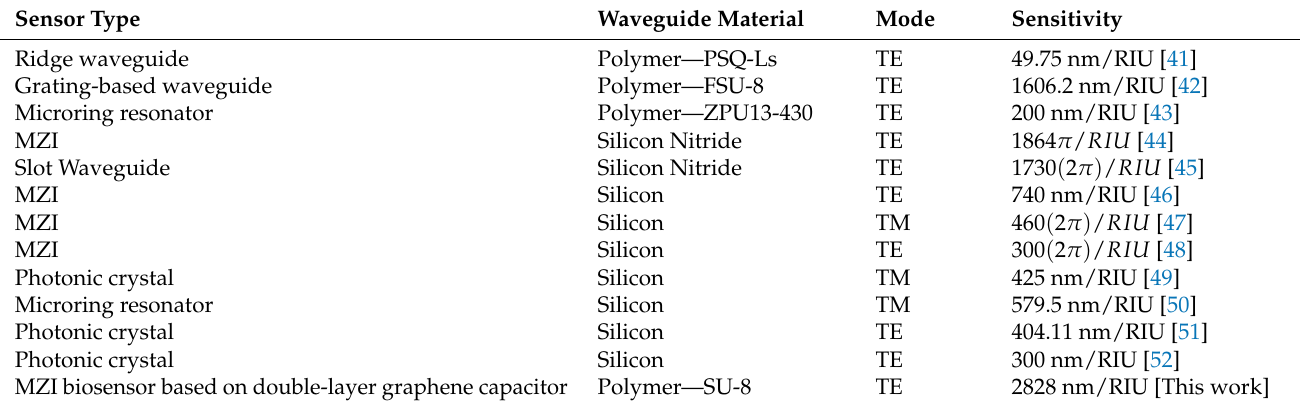
Table 1. Comparison between the proposed MZI biosensor based on double-layer graphene capacitor, with other optical biosensors presented to the scientific community, based on polymer or silicon technology. Sensor